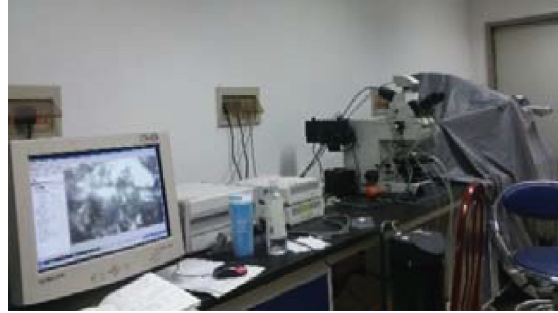
Figure 1: Thermo-stage polarizing microscope.